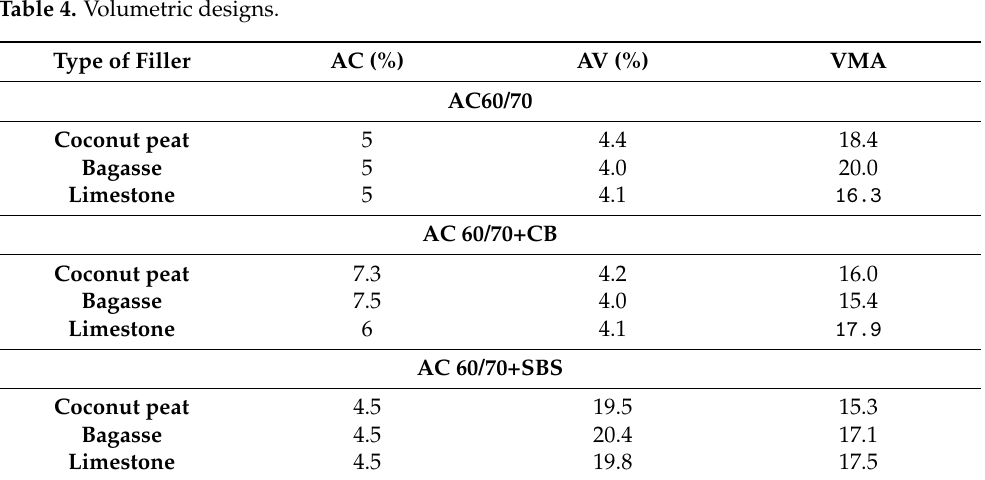
Table 4. Volumetric